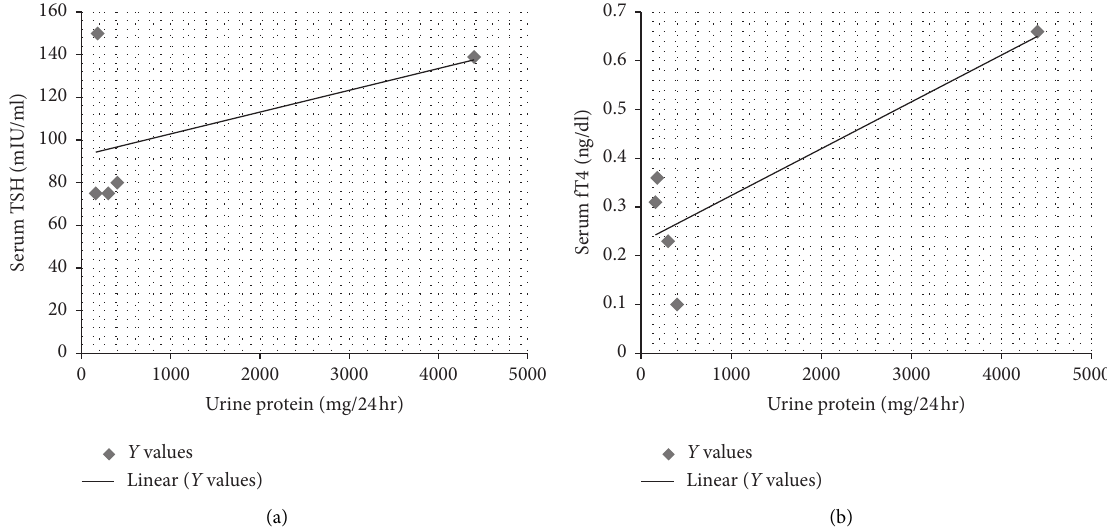
Figure 8: Correlation between proteinuria and serum TSH and fT4 levels in primary hypothyroidism in the current study. Impact of proteinuria on thyroid function tests has been shown accurately. fT4, free thyroxin; TSH, thyroid-stimulating